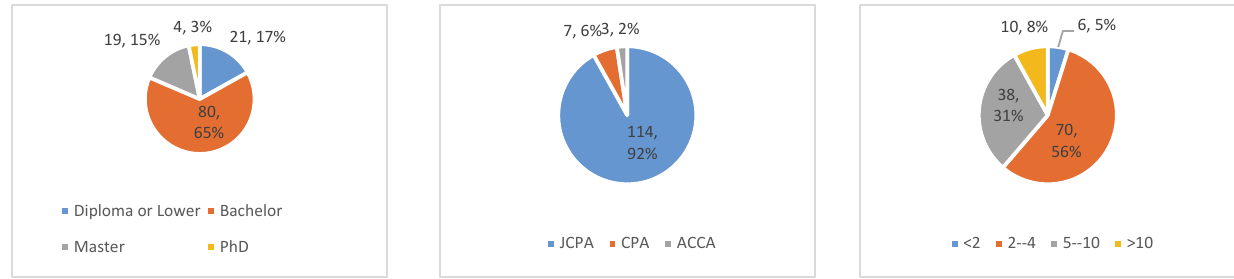
Fig. 1. Profile of the